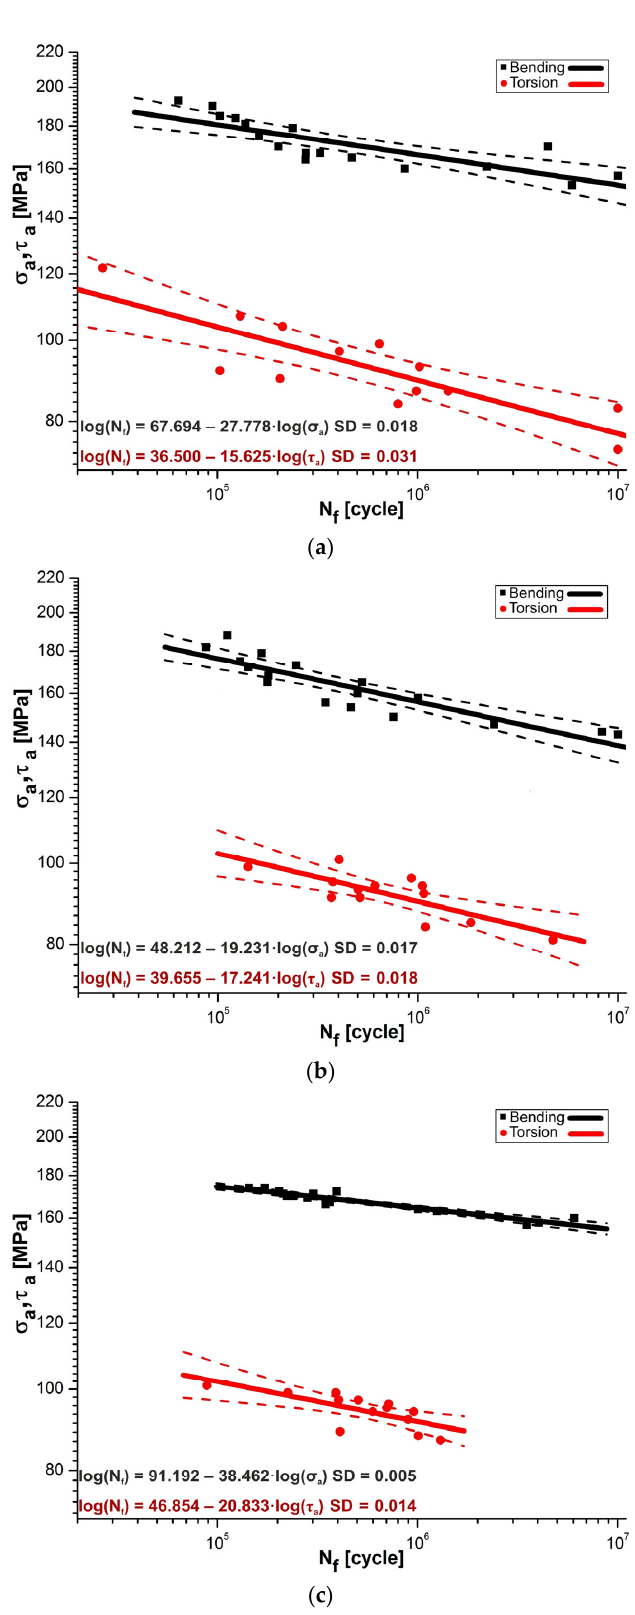
Figure 6. Basquin’s characteristics of regression lines with confidence interval ( α = 0.05) for AlZn6Mg0.8Zr alloy subjected to cold rolling in LTMP with degree of deformation of: ( a ) 10%; ( b ) 20% and ( c ) 30% after supersaturation from temperature of 500 ◦